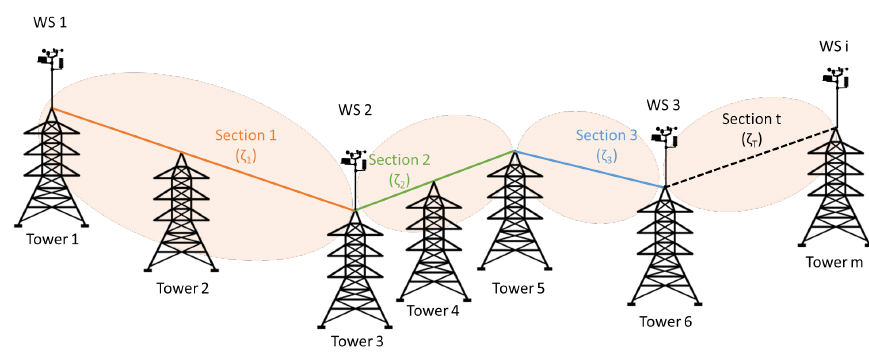
Figure 6. Parts of a theoretical line with less